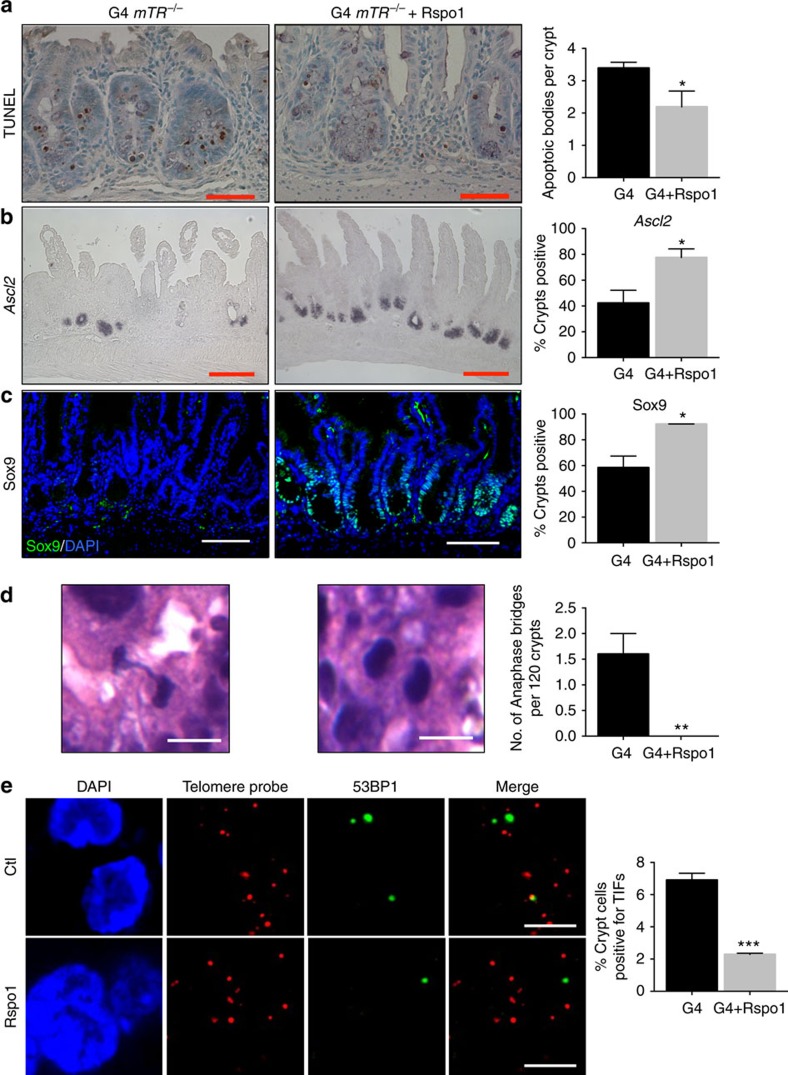
Enhanced Wnt signalling rescues G4 mTR−/− crypt dysfunction and telomere uncapping in vivo.(a) Representative images showing apoptotic changes by TUNEL staining in intestinal crypts of G4 mTR−/− mice treated for 8 days with subcutaneous injections of R-spondin1 (Rspo1) (n=4 Rspo1-treated and 5 littermate controls). Scale bars, 50 μm. (b) Representative image showing Ascl2 transcripts differences in Rspo1-treated and control G4 mTR−/− mice (n=3). Scale bars, 100 μm. (c) Representative images showing Sox9 protein differences in Rspo1-treated and control G4 mTR−/− mice (n=4 control and 3 Rspo1-treated). Scale bars, 50 μm. (d) Representative images showing reduced telomere dysfunction as measured by anaphase bridges in Rspo1-treated G4 mTR−/− mice (left, untreated; middle, Rspo1-treated). Quantitation of anaphase bridges (right). 120 crypts per mouse from 5 control G4 mice and 4 Rspo1-treated G4 mice were surveyed for anaphase bridges. Scale bars, 10 μm. (e) Representative images and quantitation (right) showing reduced telomere dysfunction as measured by TIFs in Rspo1-treated G4 mTR−/− mice (n=3). Scale bars, 5 μm. All error bars reflect s.e.m., and P values reflect unpaired two-tailed Student's t-tests, with *P<0.05, **P<0.005 and *** P<0.0005.